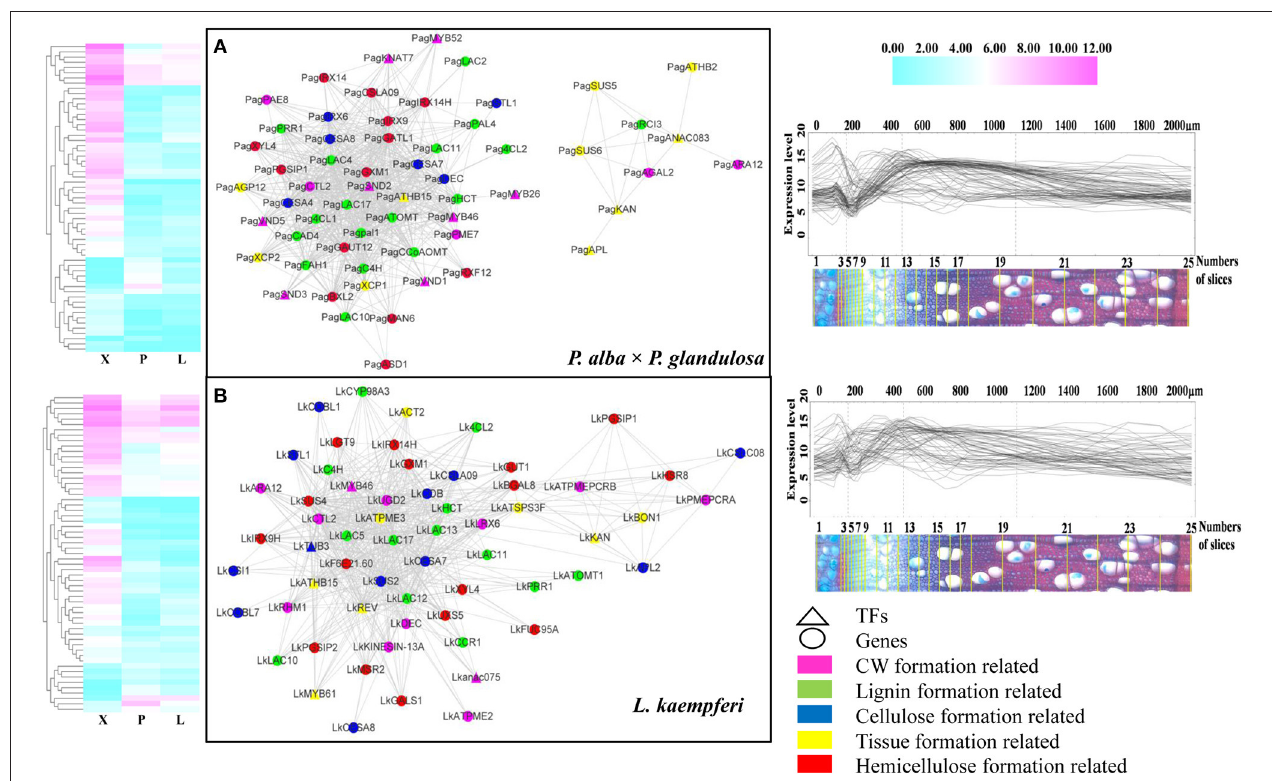
FIGURE 6 | Co-expression network of wood formation-related genes in the two tree species. (A) Network for wood formation-related genes in P. alba × P. glandulosa . (B) Network for wood formation-related genes in L. kaempferi . The heatmaps (left) and gene expression abundance curves (right) depict the corresponding genes in each co-expression network. The scales above the expression curves indicate the slice position; the scales under expression curves indicate the number of slices. Gene expression abundance curves were derived and drawn using an online tool (http://aspwood.popgenie.org).